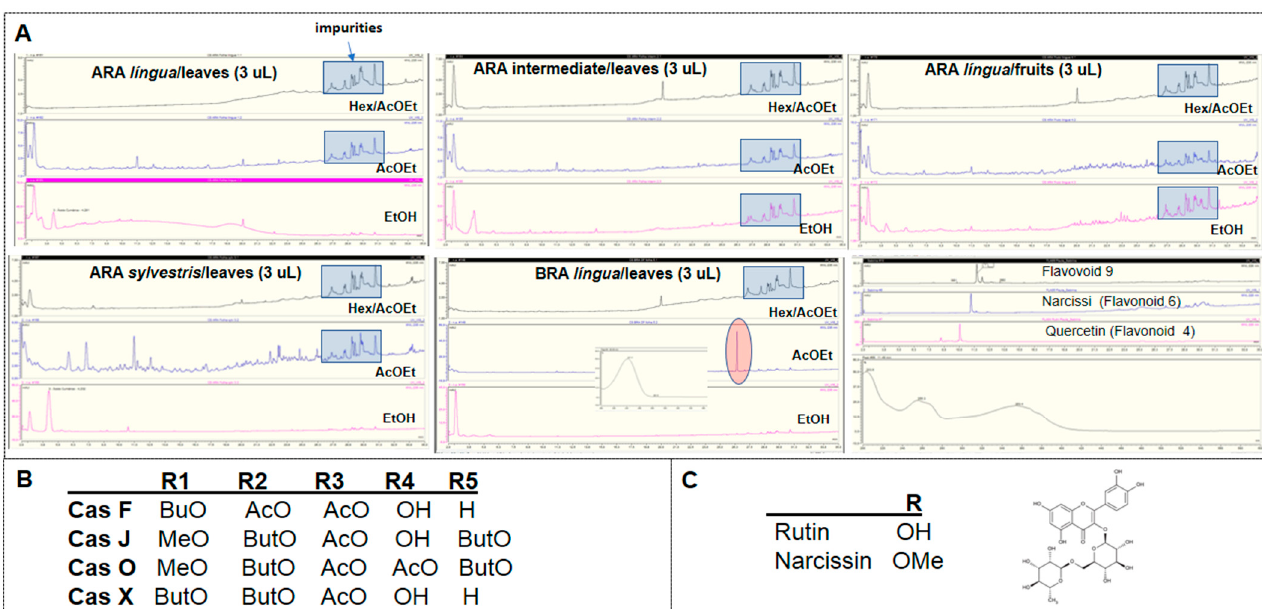
Figure A2. ( A ) The chemical profile of AcOEt fractions from C. sylvestris samples. ( B ) Substitutes of casearins, where: BuO = n-C 3 H 7 CO 2 ; MeO = OCH 3 (methoxy); AcO = CH 3 CO 2 (acetate);